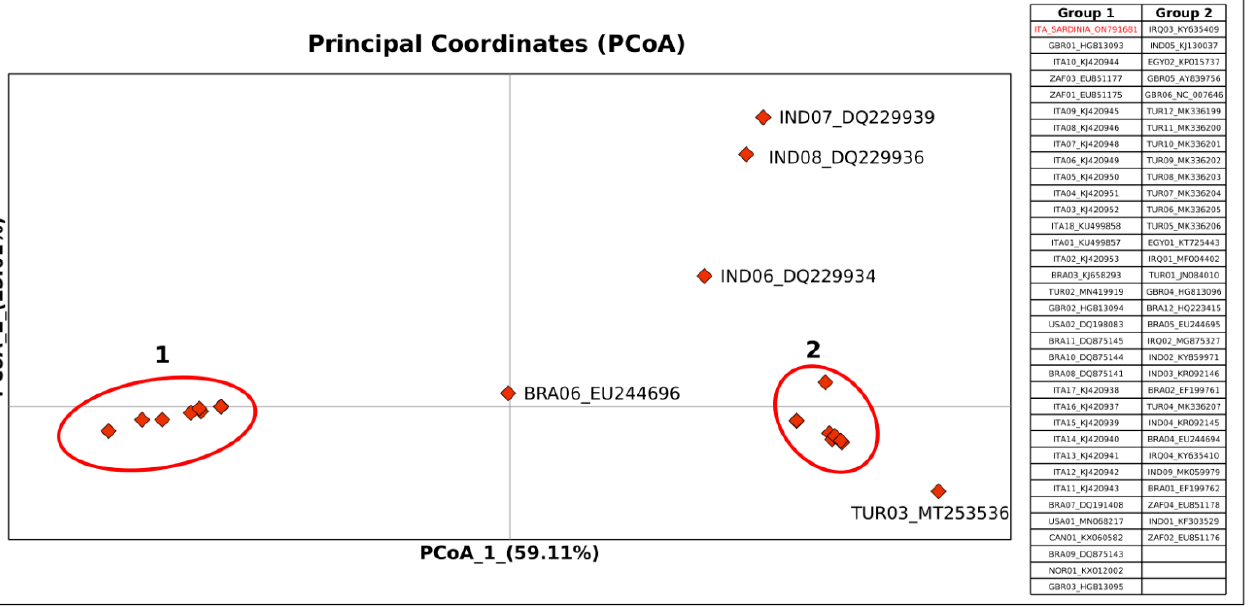
Figure 4. Principal components analysis performed on the same dataset of OvHV2 ORF75 gene fragment (131 bp) used for the phylogenetic tree analysis. Bi-dimensional plots show the genetic differentiation among strains due to the base differences per site found in the dataset. The ORF75 gene sequence isolated in Sardinia is indicated in red font.